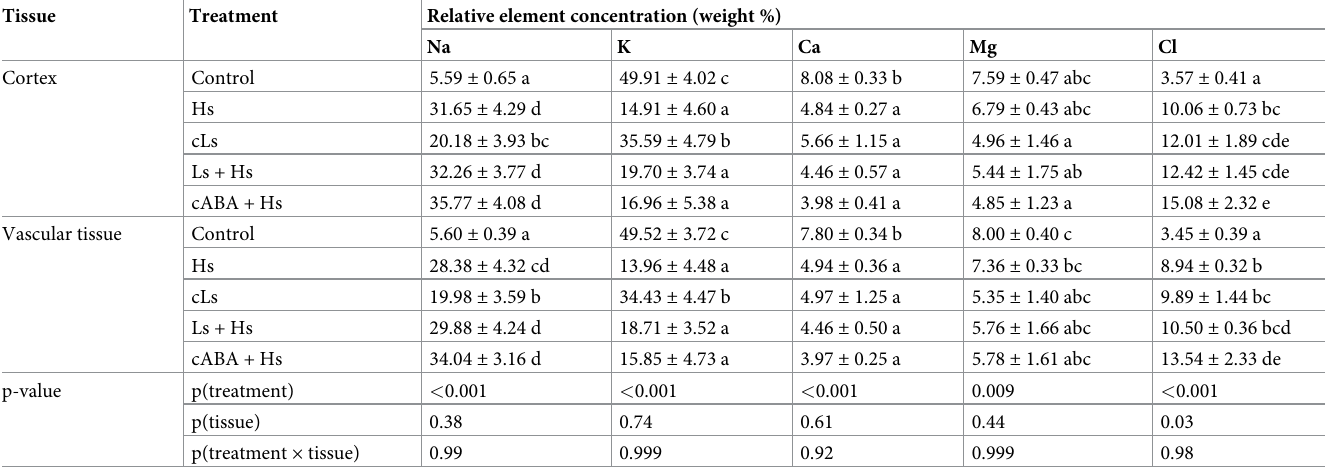
Table 1. Relative concentration of Na, K, Ca, Mg and Cl in the cortex and the vascular tissues of root of P . × canescens from EDX analysis.